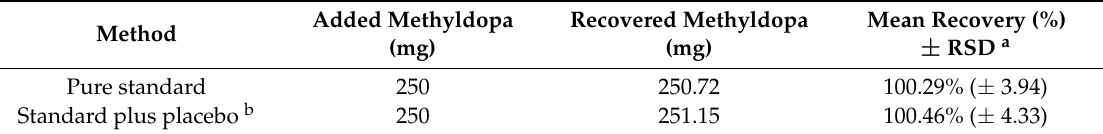
Table 4. Results obtained for the determination of methyldopa in standard and standard plus placebo solutions.